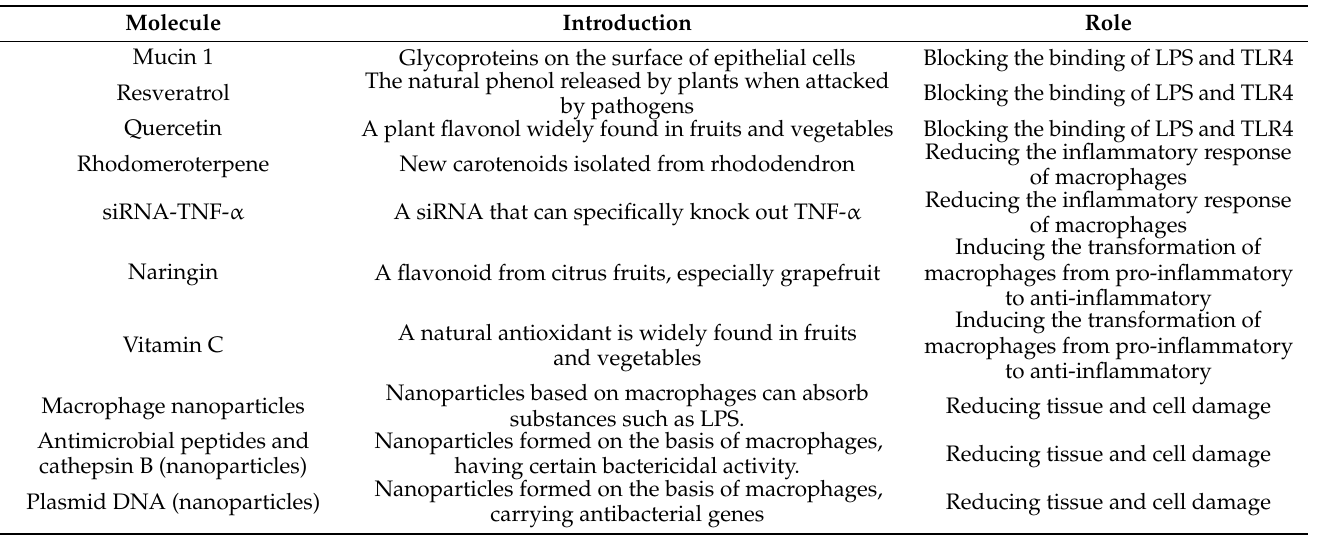
Table 2. Treatment of